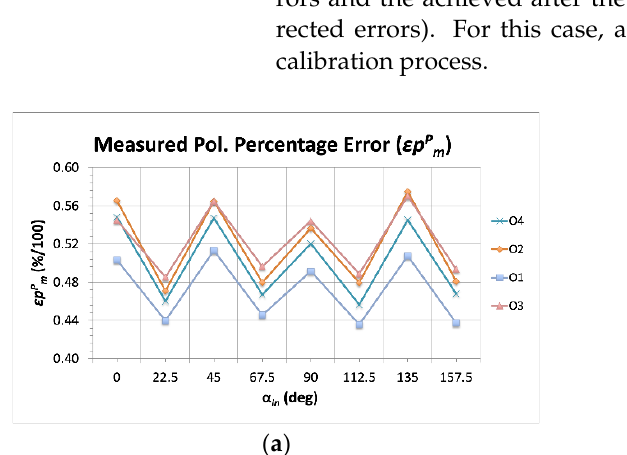
Figure 6. Measured polarization percentage error ( ε p Pm , ( a )) compared to the corrected ones ( ε p Pc , ( b )). The calibrated errors are represented here as a function of the input polarization angles ( α in ). Table 3. Fitting parameters K i for each error term and polarimeter output.